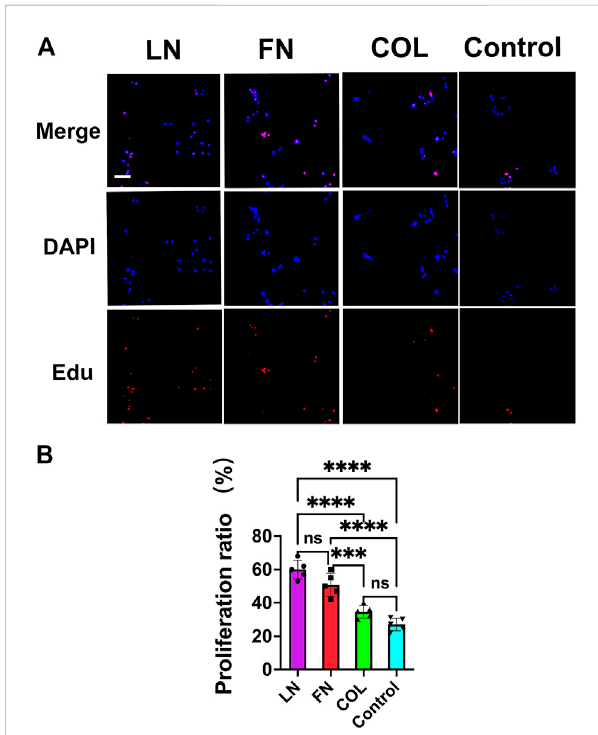
FIGURE 3 The proliferation of SCs under 2D culture conditions (EdU staining).Twenty-fourhoursafterseedingSCs,theproliferationofSCs in the LN, FN and type IV Col groups were observed under a fl uorescence microscope (A) , and the proportion of proliferating cells was quanti fi ed [ (B) , n = 5]. The proportion of proliferating cells (red) in the LN group and FN group was signi fi cantly greater than that in the type IV Col group and Control group ( p < 0.0001). *** p < 0.001, **** p < 0.0001, ns p > 0.05. One-way ANOVA with Tukey ’ s post-hoc test. Scale bar = 4